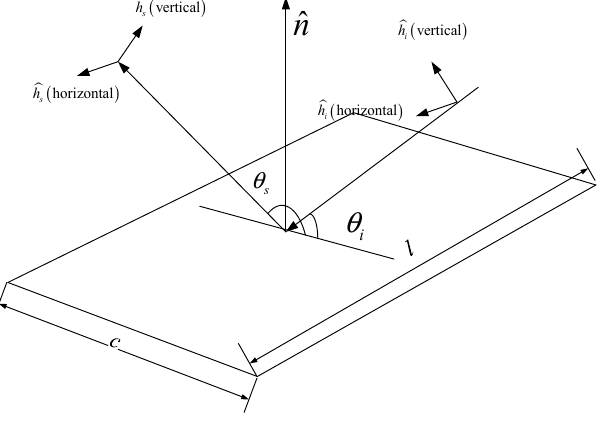
Figure 7. Sketch of the illusion of radar on a plate.